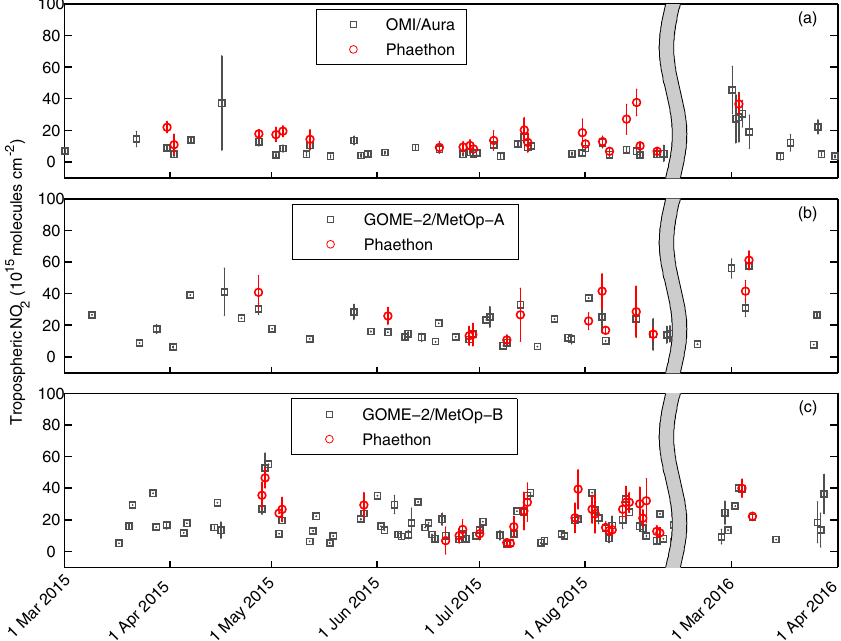
Figure 7. Tropospheric NO 2 in Guangzhou from MAX-DOAS measurements at the elevation angles of 15 and 30 ◦ and the satellite sensors OMI (a) , GOME-2A (b) and GOME-2B (c) corresponding to cloud fraction ≤ 0.3. Ground-based measurements are averages of 1h centered at the satellite overpass time. The error bars represent the measurement error. The grey shaded area stands in for the time period during which the MAX-DOAS was not operating.